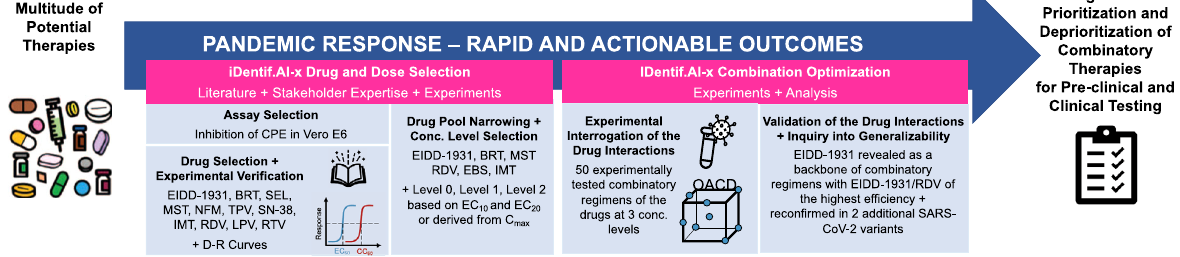
Fig. 1 IDentif.AI-x work fl ow and its alignment with the pandemic response therapies prioritization. IDentif.AI-x systematically ranks drug combinations for further preclinical and potentially clinical deployment from a multitude of potential therapies. Clinical applicability considerations are integrated into IDentif.AI-x work fl ow to pre-emptively best position the optimized combinations for a clinical translation. EIDD-1931 (metabolite of EIDD-2801 (molnupiravir)), baricitinib (BRT), ebselen (EBS), selinexor (SEL), masitinib (MST), nafamostat mesylate (NFM), telaprevir (VX-950; TPV), SN-38 (metabolite of irinotecan), imatinib mesylate (IMT), remdesivir (RDV), lopinavir (LPV), and ritonavir (RTV) were included in the original pool in this study. CPE cytopathic effects. D-R dose-response. OACD orthogonal array composite